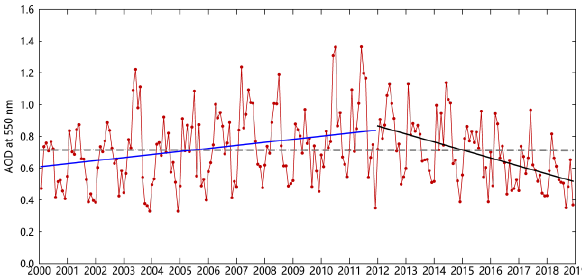
Figure 5. Time series of the averaged monthly mean AOD at 550 nm in HER from 2000 to 2018. The straight lines represent trend lines calculated by using linear regression analysis (blue solid line: 2000-2011, black solid line: 2012-2018, and gray dotted line: